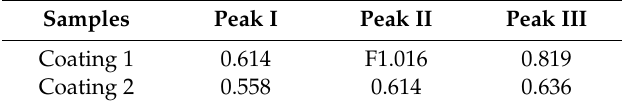
Figure 13. The elemental distributions of area H in Figure 10c. Table 4. FWHM values of the three primary peaks in coating 1 and coating 2 (2 θ / ◦ ). Samples